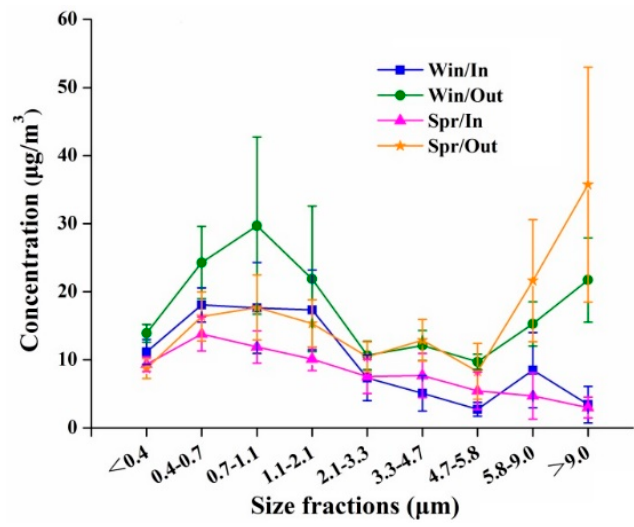
Figure 1. Mass concentrations of indoor/outdoor SSAs in winter and spring ( n = 5) (Win: Winter; Spr: Spring; In: Indoor; Out: Outdoor).